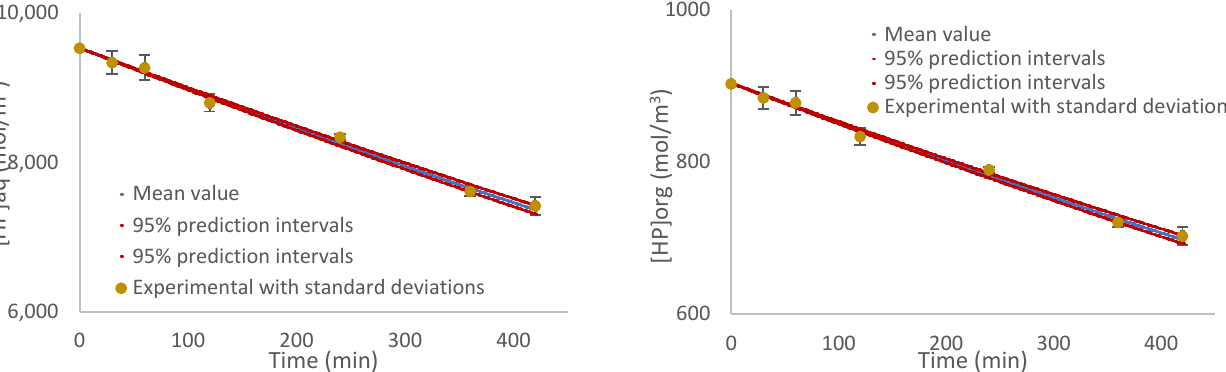
Figure A3. Prediction intervals of 95% for the concentration of hydrogen peroxide in the aqueous and organic phases, using the average of the experimental data and setting K 1,org = 0 and K 1,aq = 15.05 for Experiment 3.